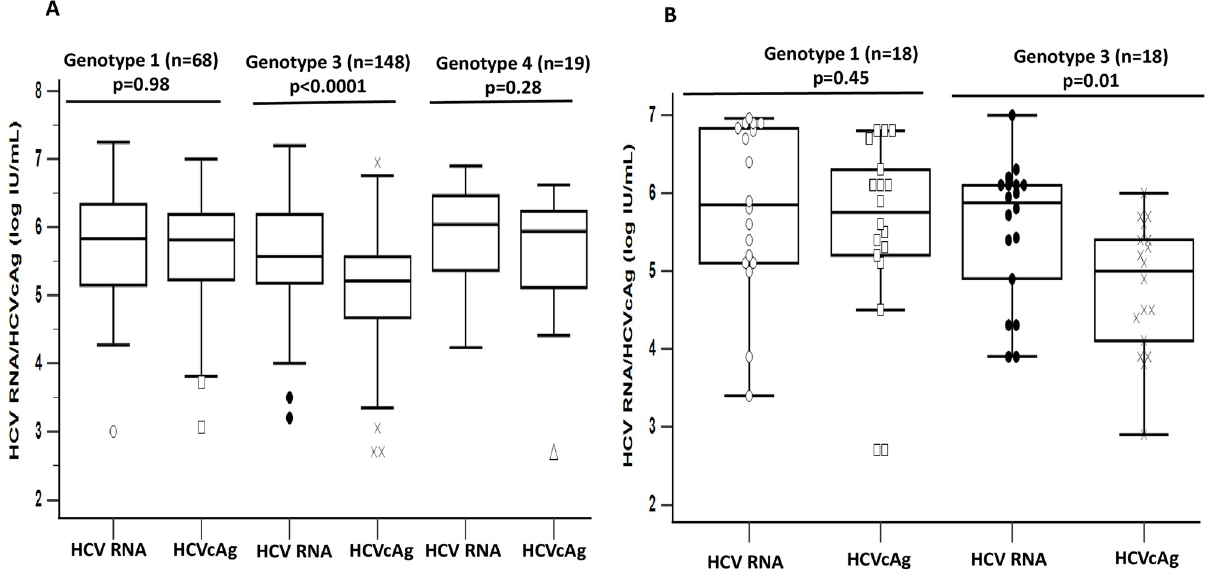
Fig 7. Baseline HCV RNA and HCVcAg levels in various genotypes (A) Treatment-na ï ve (B) Previously treated. Abbreviations: HCV, hepatitis C virus; RNA, ribonucleic acid; HCVcAg, hepatitis C virus core antigen.